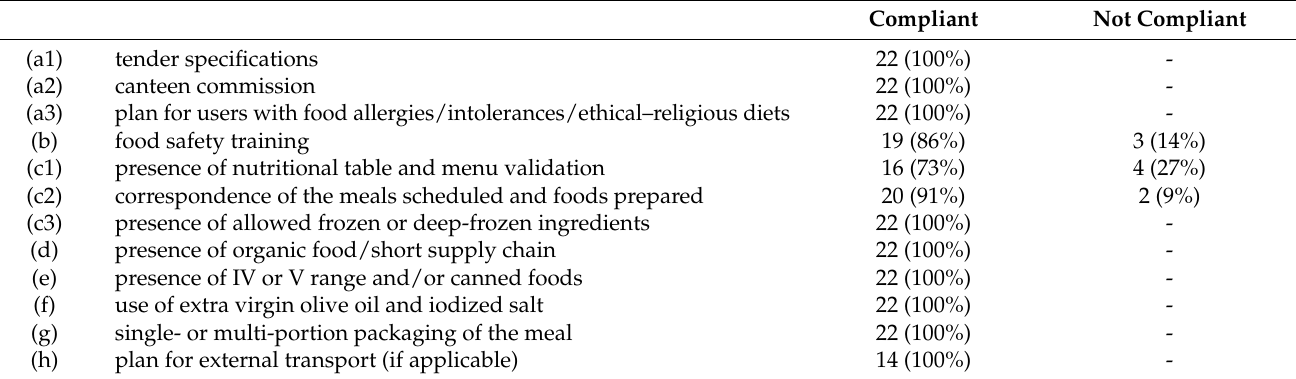
Table 4. OC—Nutritional section (classified in 2